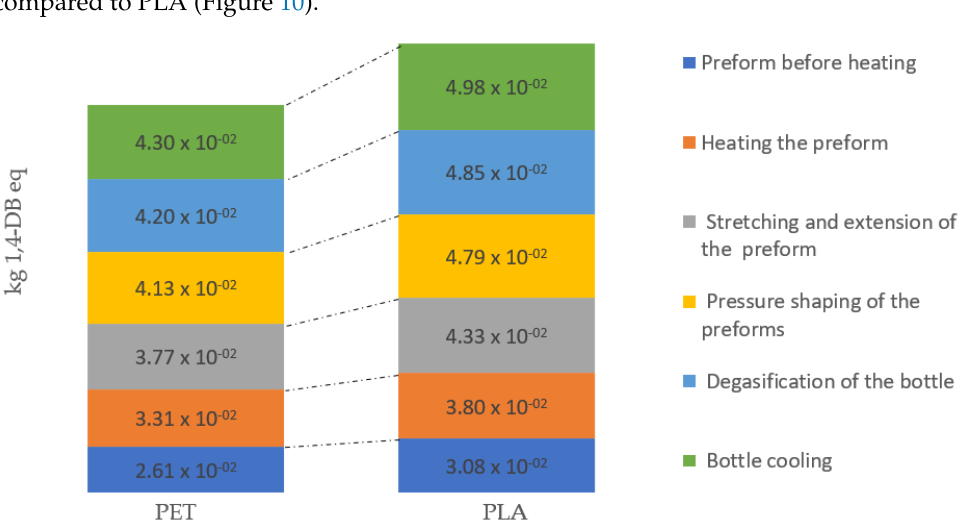
Figure 9. Human toxicity emissions throughout the entire bottle shaping process.